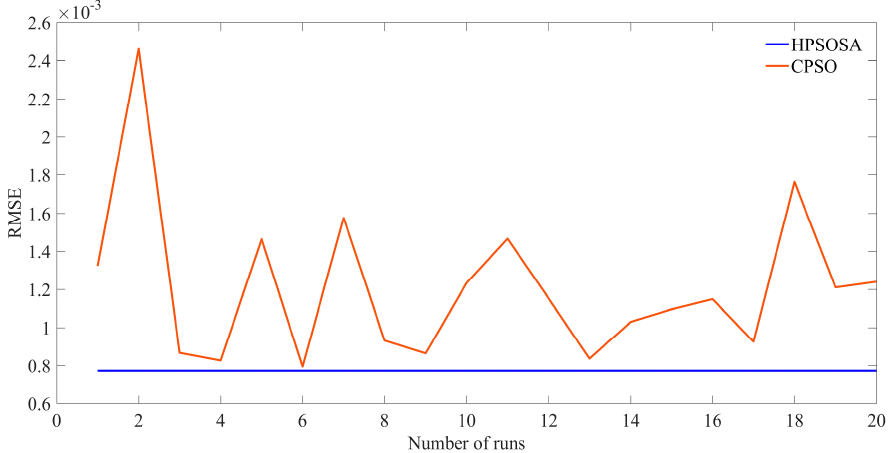
Figure 4. Comparison of the HPSOSA and the CPSO for 20 runs.